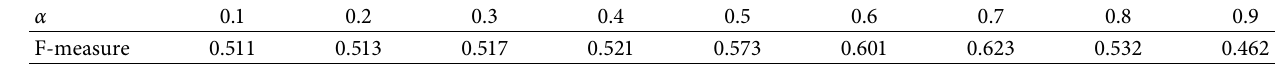
Table 2: F-measure value when the number of similar users is 60.